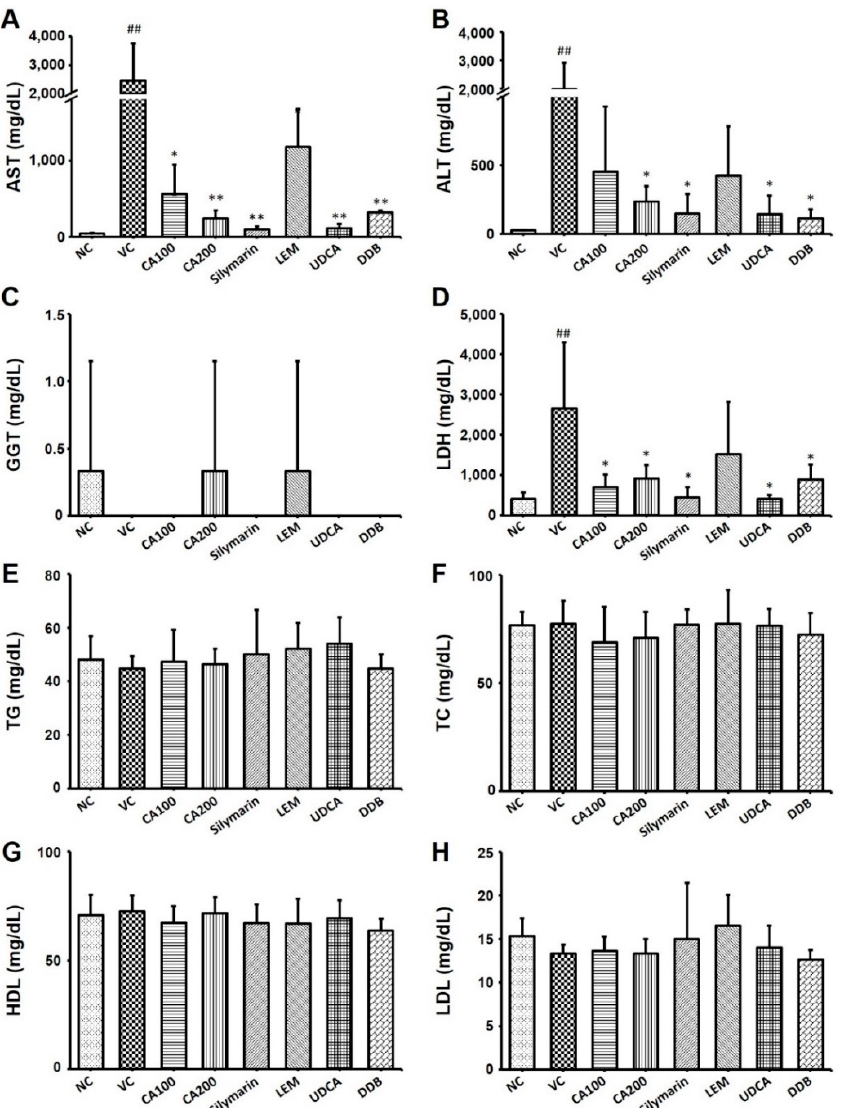
Figure 3. Effects of CA-HE50 on liver damage and blood lipids in LPS/D-Gal-induced ALF animal model. The serum levels of ( A ) AST, ( B ) ALT, ( C ) GGT, ( D ) LDH, ( E ) TG, ( F ) TC, ( G ) HDL and ( H ) LDL were investigated. NC, normal control; VC, vehicle control; CA100, 100 mg/kg CA-HE50; CA200, 200 mg/kg CA-HE50; Silymarin, 100 mg/kg silymarin; LEM, 200 mg/kg LEM; UDCA, 25 mg/kg UDCA; DDB, 200 mg/kg DDB. Data are represented as mean ± SD ( ## p < 0.01 vs. normal control; * p < 0.05 or ** p < 0.01 vs. vehicle control).